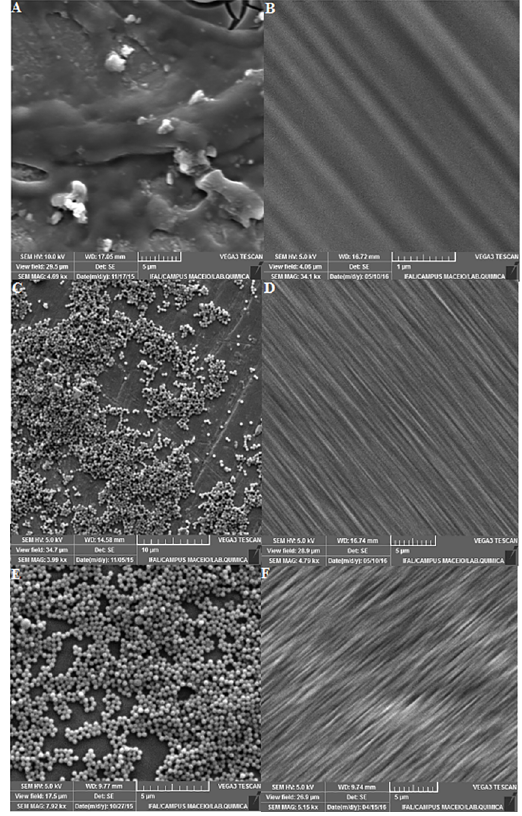
Figure 3. SEM microphotographies of latex beads films: (A) - SHI; (B) - GSI; (C) - SHIII; (D) - GSIII; (E) - SHIV; (F) -